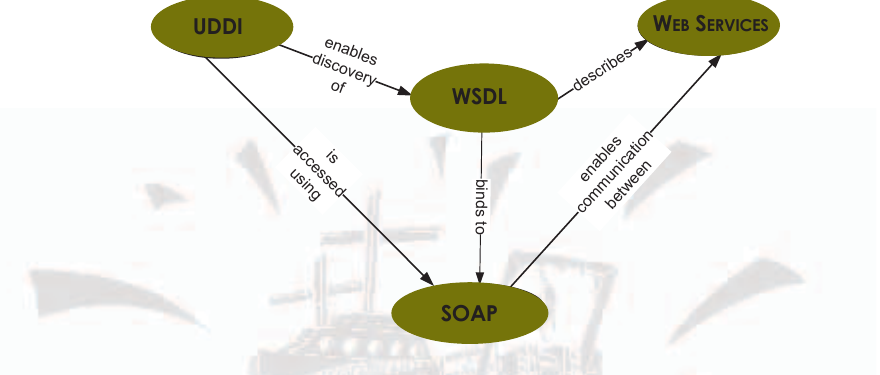
FIGURE 6: RELATIONSHIP BETWEEN WEB SERVICES ENABLING TECHNOLOGIES